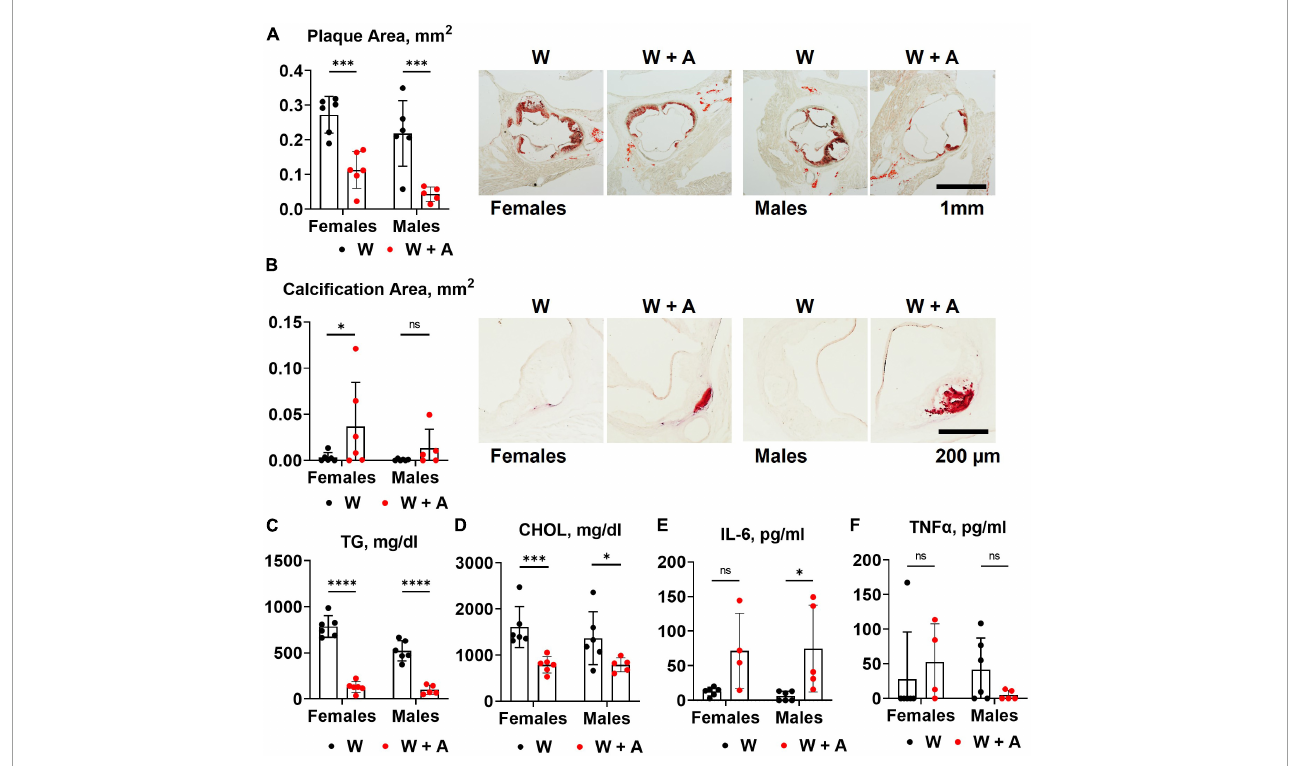
FIGURE2 Aortic root atherosclerosis, plasma lipids, and inflammatory cytokines in WHC mice treated with a western with or without adenine. (A) Representative images and quantification of Oil red O staining of the aortic root. (B) Representative images and quantification of alizarin red staining of the aortic root.